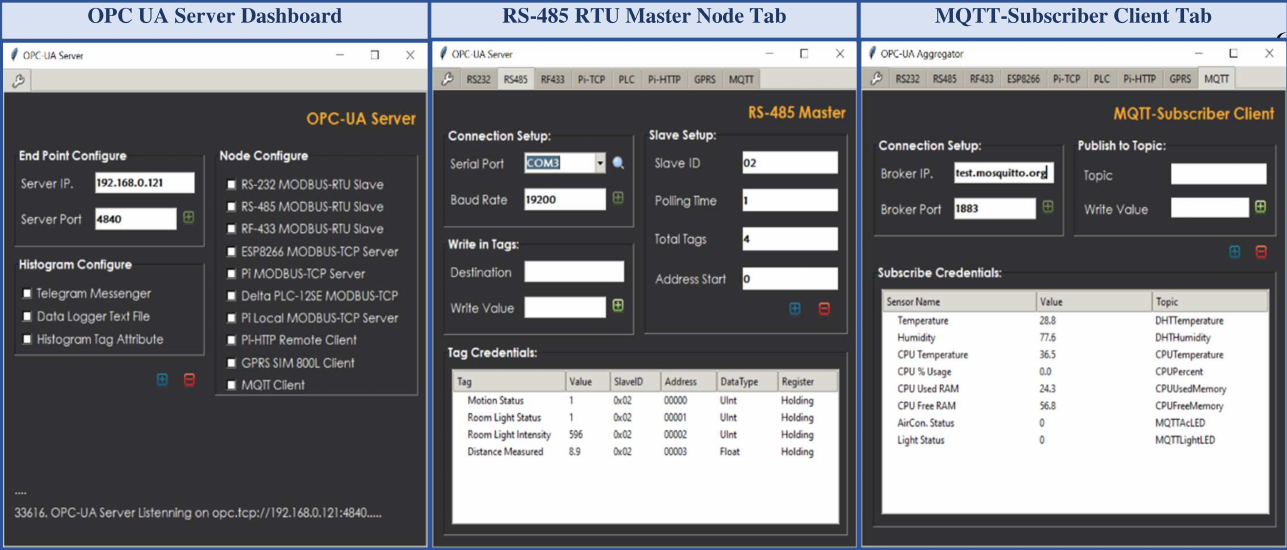
Figure 4. GUI application of the developed OPC UA server.